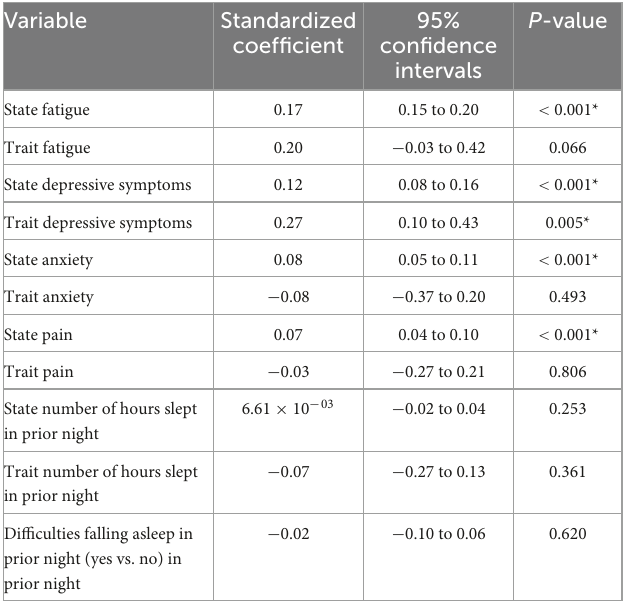
TABLE 6 Model estimates for real-time associations between non-cognitive symptom ratings and self-reported cognitive dysfunction.